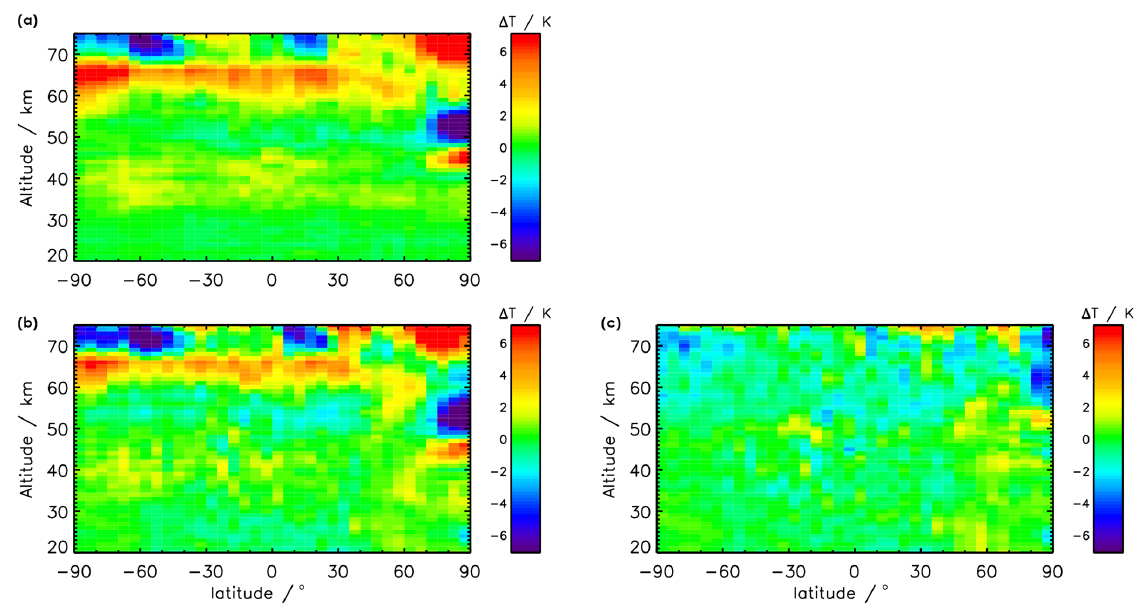
Figure 9. Temperature differences for 20 February 2009. (a) V8 nominal-mode minus V5 nominal-mode data. (b) V5 middle-atmosphere mode minus V5 nominal-mode data. (c) V5 middle-atmosphere mode minus V8 nominal-mode data. Specifically, the used data versions are V5R_T_221 (NOM), V5R_T_521 (middle atmosphere), and V8R_T_261